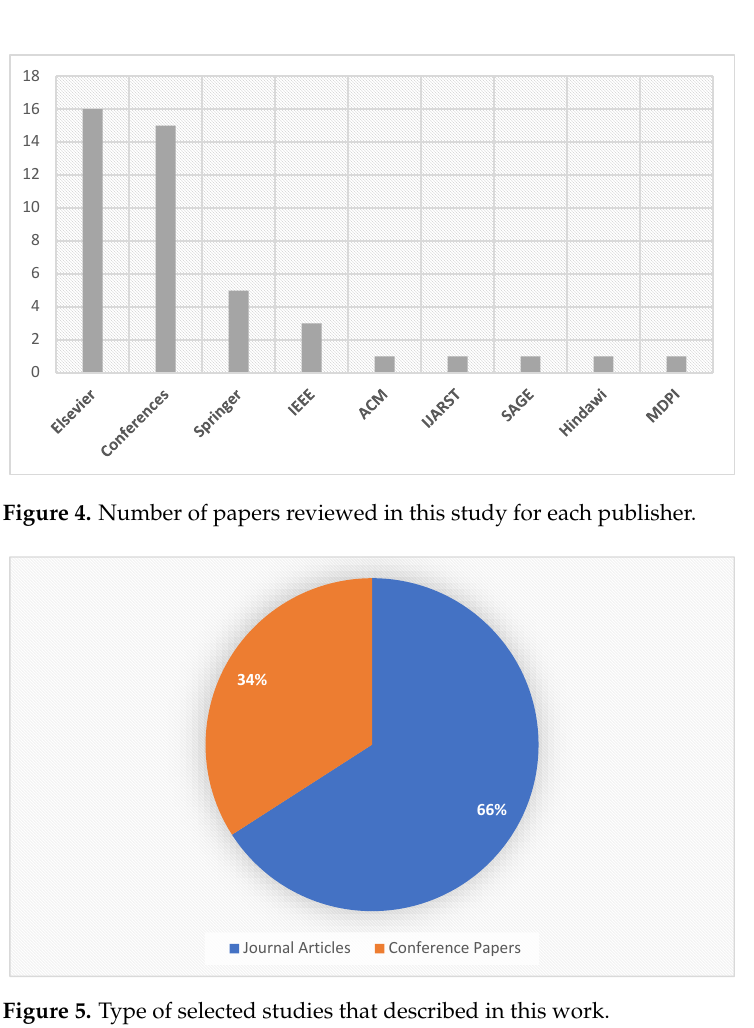
Figure 5. Type of selected studies that described in this work.